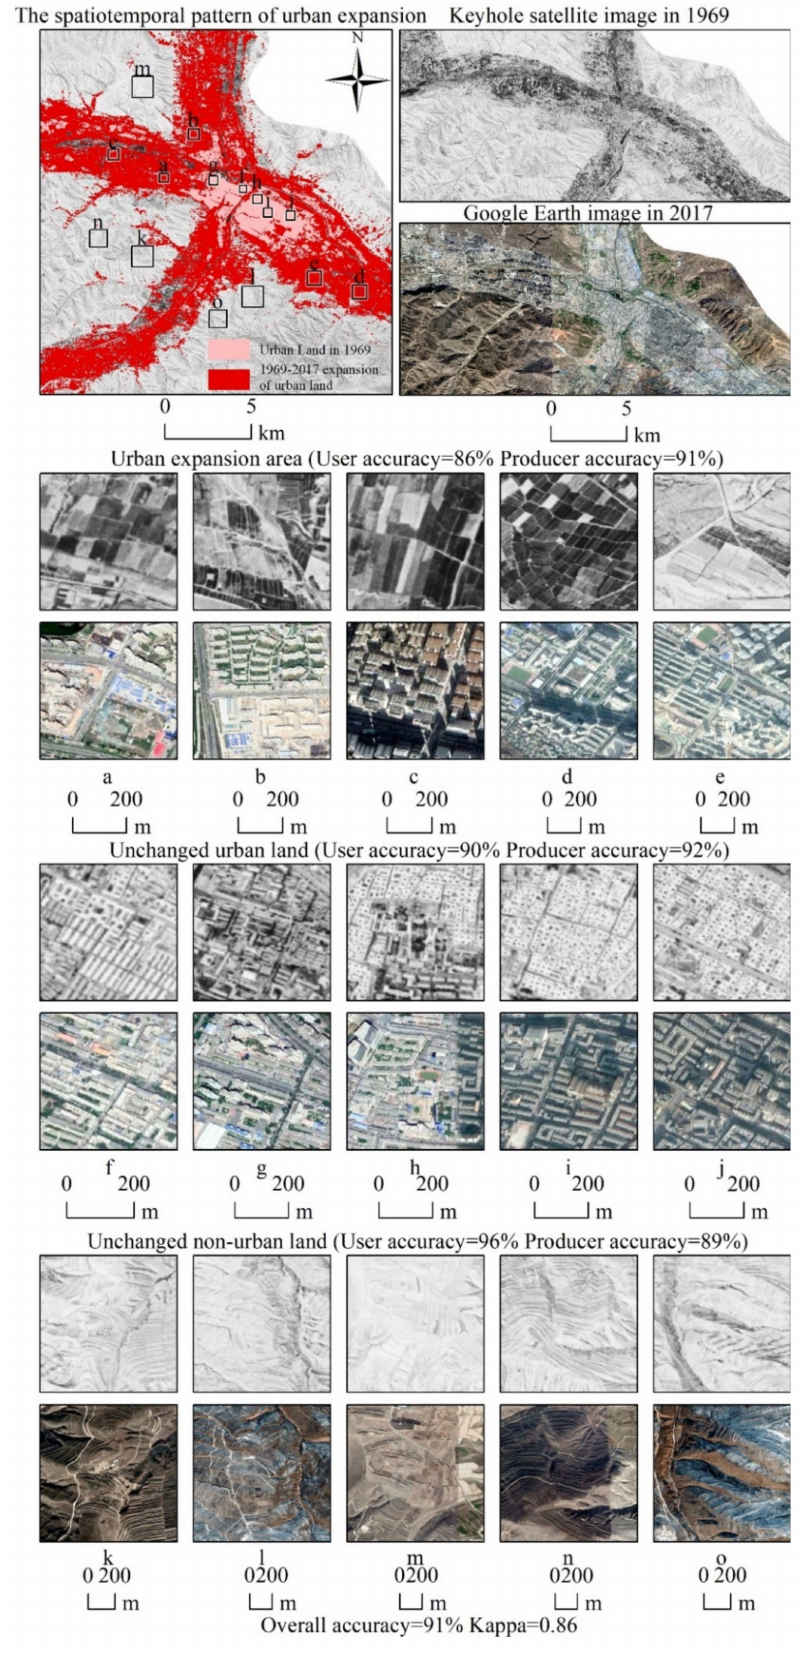
Figure 9. Accuracy assessment based on high-resolution remote sensing